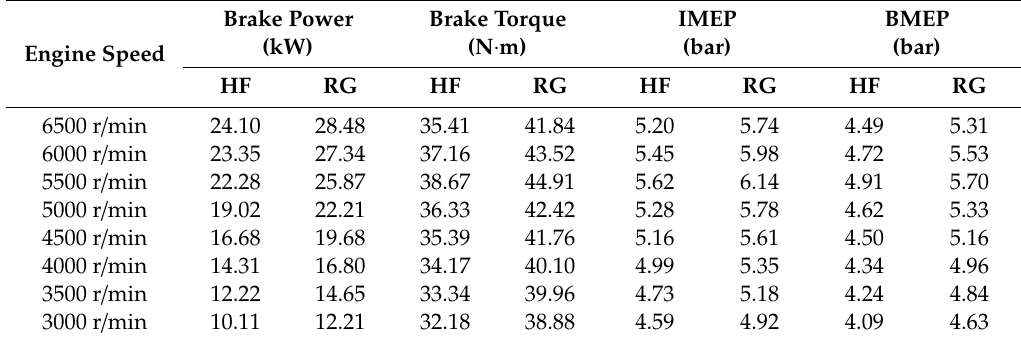
Table 17. Simulation results of engine speed characteristics (throttle valve opening = 100%).